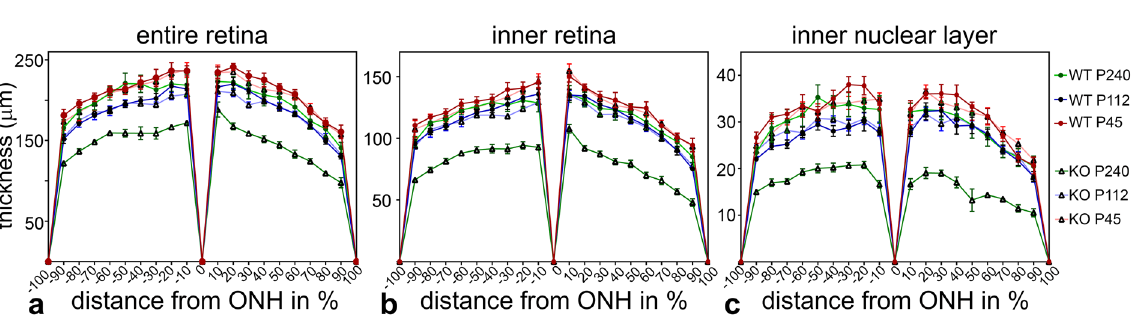
Figure 6. Expression of SQSTM1/p62 in the retina of Ppt1 ko mice. ( A ) SQSTM1/p62-positive aggregates were detectable in the retina of 45-day-old mutants (Ab) and increased in number and size with increasing age of the animals (Ac,Ad). Note that the immunoreactive punctae were restricted to the inner nuclear layer at all ages analyzed (Ab–Ad). Wild-type retinas were devoid of SQSTM1/p62-positive punctae (for a 240-day-old animal, see Aa). ( B ) There was either no or only partial co-localization of SQSTM1/p62-positive aggregates (Ba) with LAMP1 (Bb) in P240 Ppt1 ko retinas (arrowheads in Ba–Bc). ( C ) Immunoblot analyses of retinas at P240 confirmed markedly elevated levels of SQSTM1/p62 in mutant retinas when compared to control retinas. GAPDH immunoblotting was performed as a loading control. Positions of the molecular mass markers are indicated. Uncropped blots are shown in Supplementary Fig. 5. gcl: ganglion cell layer; inl: inner nuclear layer; ipl: inner plexiform layer; onl: outer nuclear layer. Scale bar in (Ad) for (Aa–Ad): 100 µ m; in (Bc) for (Ba–Bc): 10 µ m.